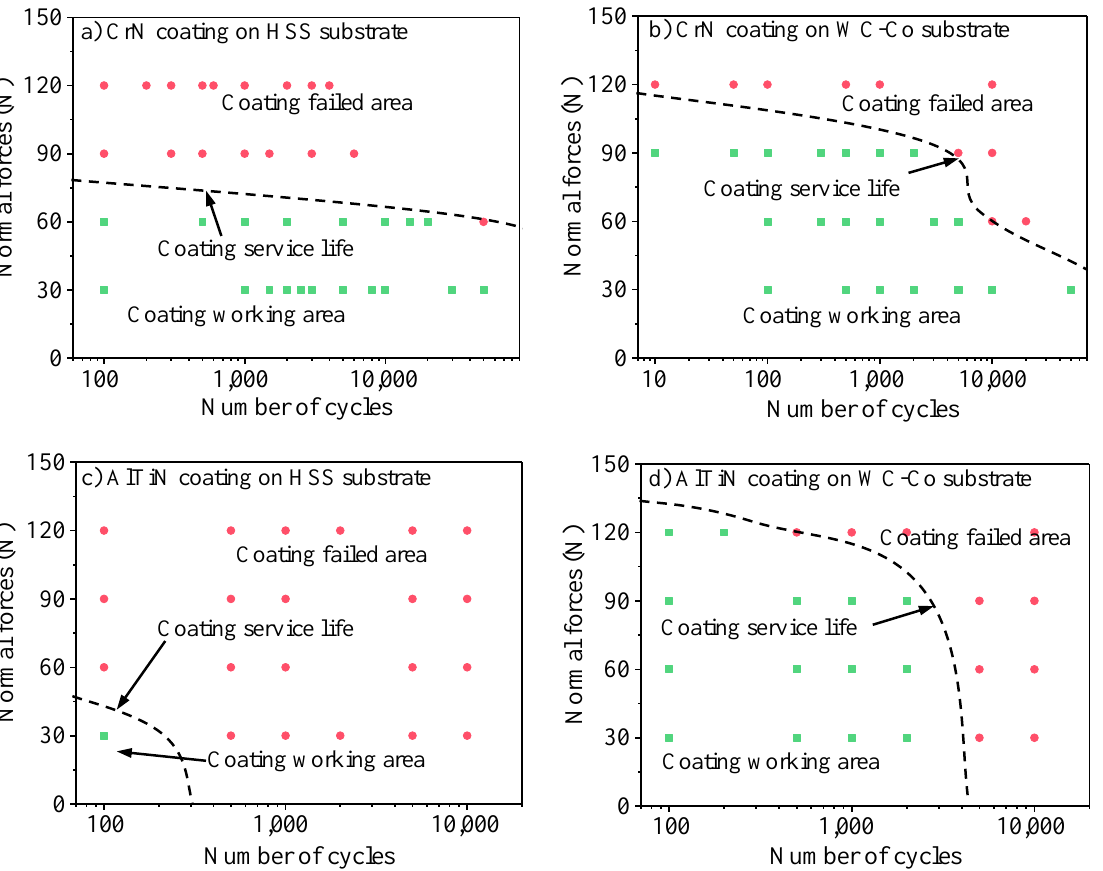
Figure 17. Coating service life maps: ( a ) CrN coating on the HSS substrate; ( b ) CrN coating on WC- Co substrate; ( c ) AlTiN coating on HSS substrate; ( d ) AlTiN coating on WC-Co substrate.